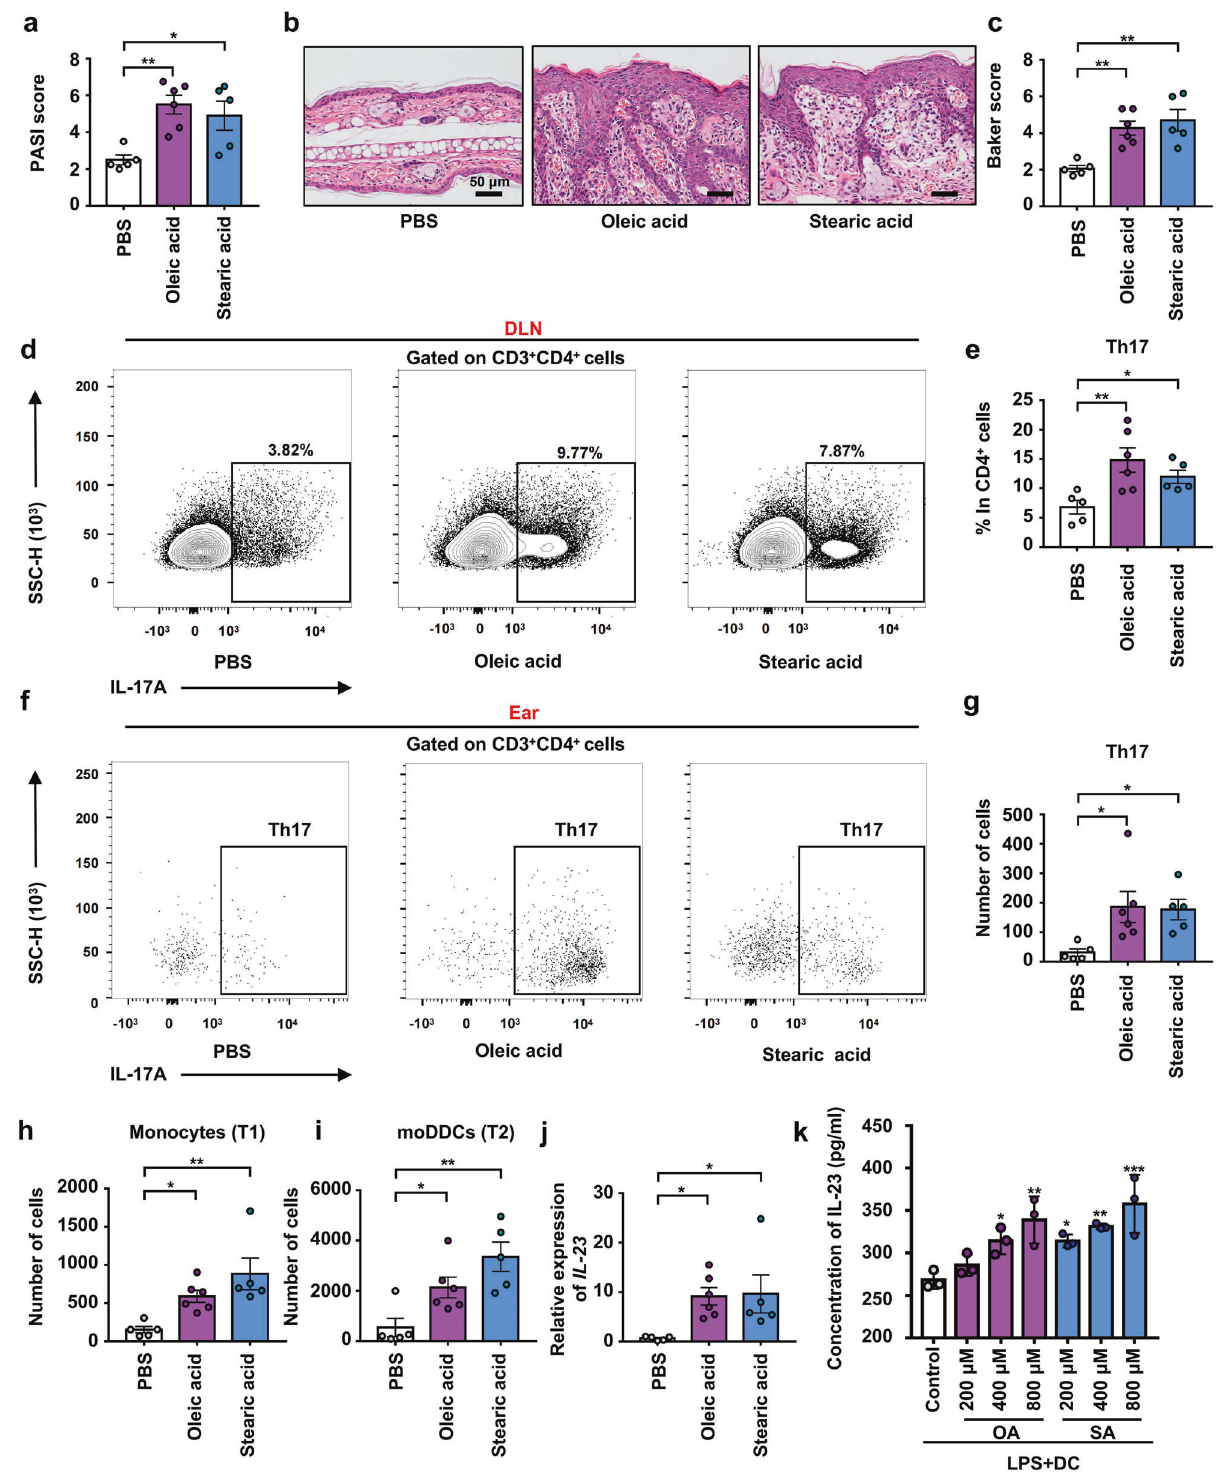
Fig. 7 Administration of free fatty acid exacerbated the pathogenesis of psoriasis-like skin phenotype of 2 M K14-VEGF mice and promoted the differentiation of Th17 in DLN as well as increased the in fi ltration of moDDCs and Th17 in ears. a PASI score of ears in PBS, oleic acid, and stearic acid group mice. b Representative H&E staining of ears (Scale bars: 50 μ m). c Pathological score of ear sections using the Baker scoring system. d Analysis of Th17 cells (CD4 + IL-17 + ) by fl ow cytometry in DLNs. e Percentage of Th17 cells in CD4 + cells. f Analysis of Th17 cells (CD4 + IL-17 + ) by fl ow cytometry in ears. g Number of Th17 cells in ears. h Number of Monocytes in ears. i Number of moDDCs in ears. j Relative mRNA expression of IL-23 in the ears of PBS, oleic acid, and stearic acid group mice. k L-23 concentrations in the culture supernatants were measured by ELISA. Data presented as mean ± SD on relevant graphs. * P ≤ 0.05; ** P ≤ 0.01; *** P ≤ 0.005 (one-way ANOVA). PBS ( n = 5), oleic acid ( n = 6), and stearic acid ( n = 5) in ( a – j ) and ( n = 3) in ( k ). OA oleic acid and SA stearic acid